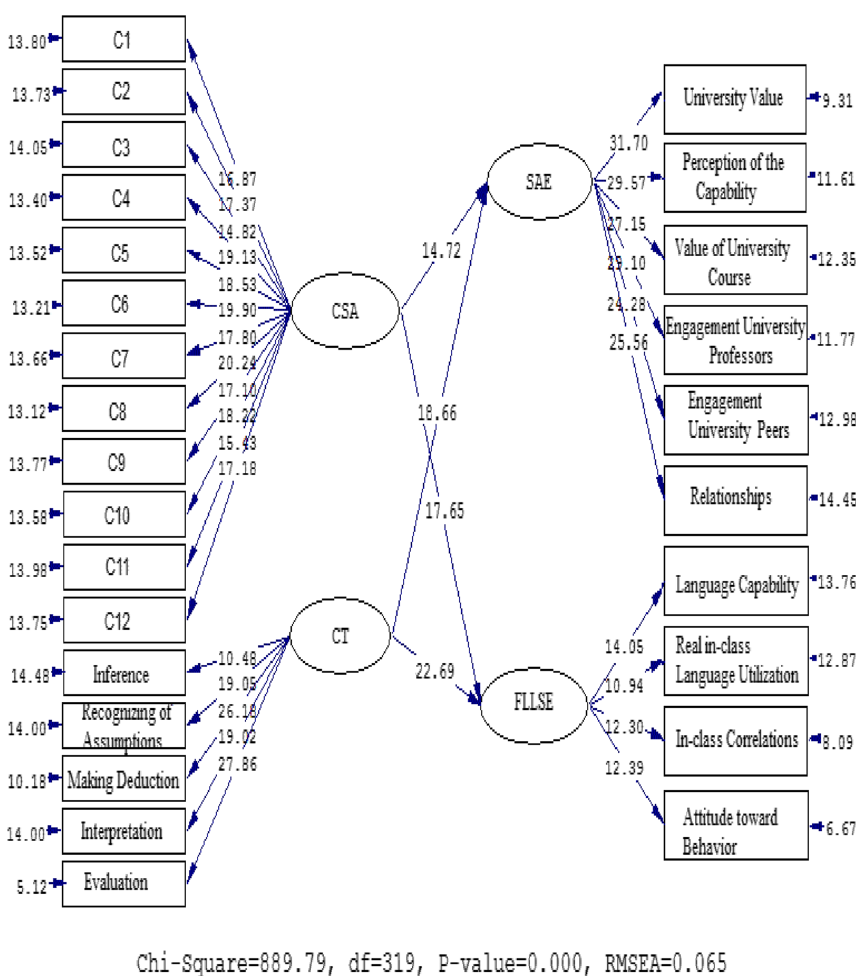
Fig. 4 Schematic representation of path coefficient values for the relationships between CSA, CT, FLLSE subscales, and SAE subscales (model